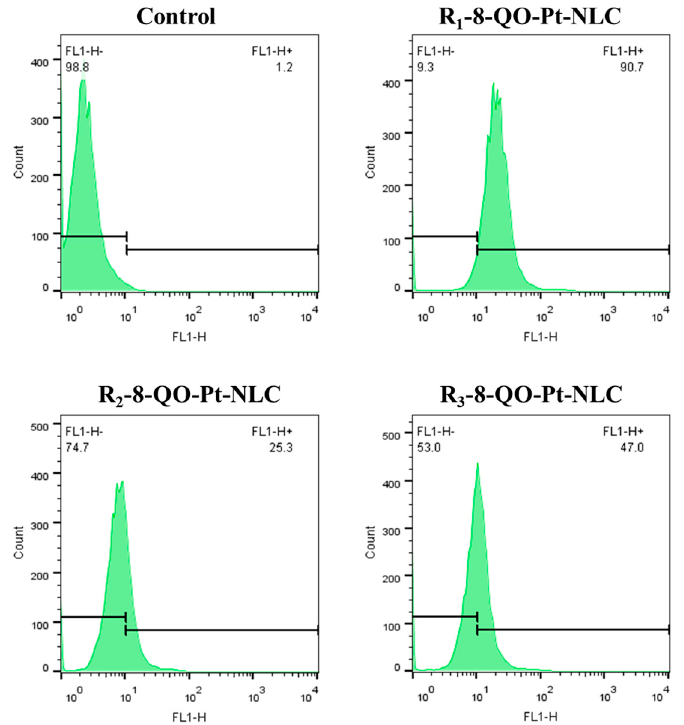
Figure 4. Cellular uptake of DiOC18-loaded empty ( − ) nanoparticles of NLC/RFV in HT-29 cells measured by flow cytometry. The cells were incubated for 24 h at a concentration equivalent to 2.5 µM of 8-QO-Pt-loaded (+) formulations of NLC/RFV.